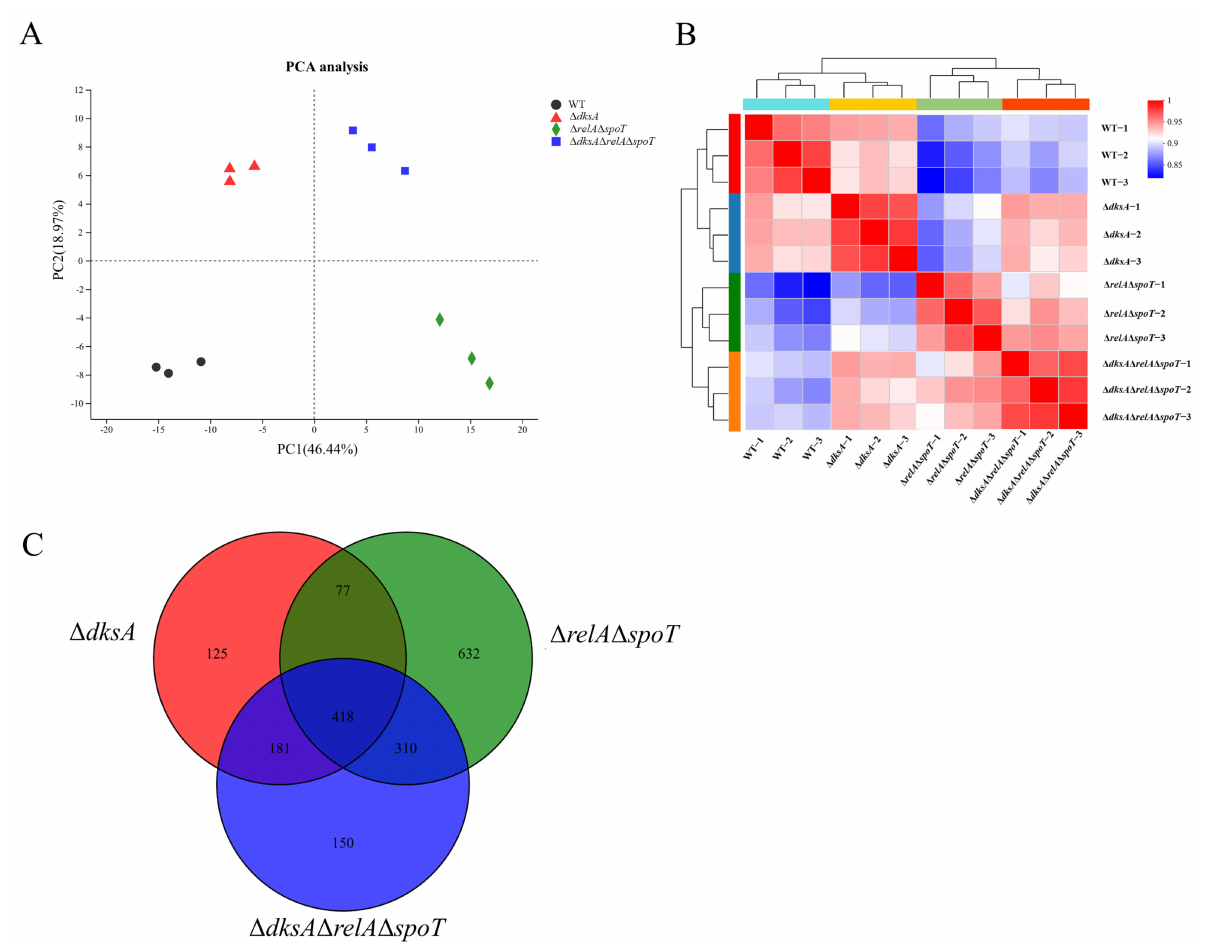
Figure 1. Expression analysis between samples. ( A ) Principal component analysis of twelve samples. ( B ) Correlation analysis of twelve samples. ( C ) Venn diagram of overlapping DEGs between ∆ dksA , ∆ relA ∆ spoT , and ∆ dksA ∆ relA ∆ spoT